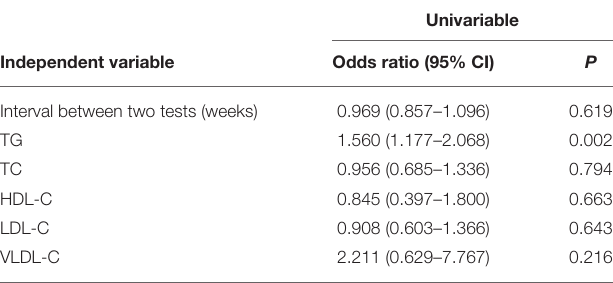
NHANES (26) and UK Biobank studies (27) TG demonstrated the strongest positive association with leukocyte count. Hu et